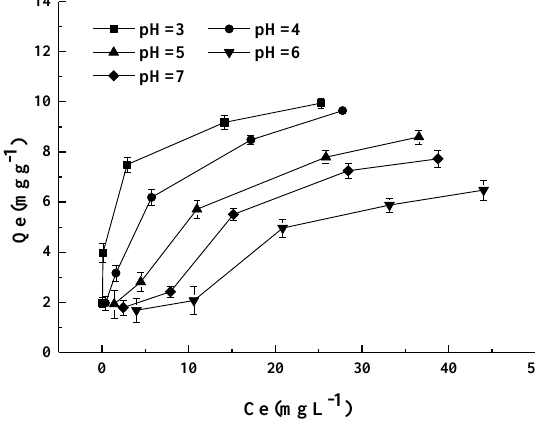
Figure 7. The effect of pH on adsorption by FMCBC 3 .